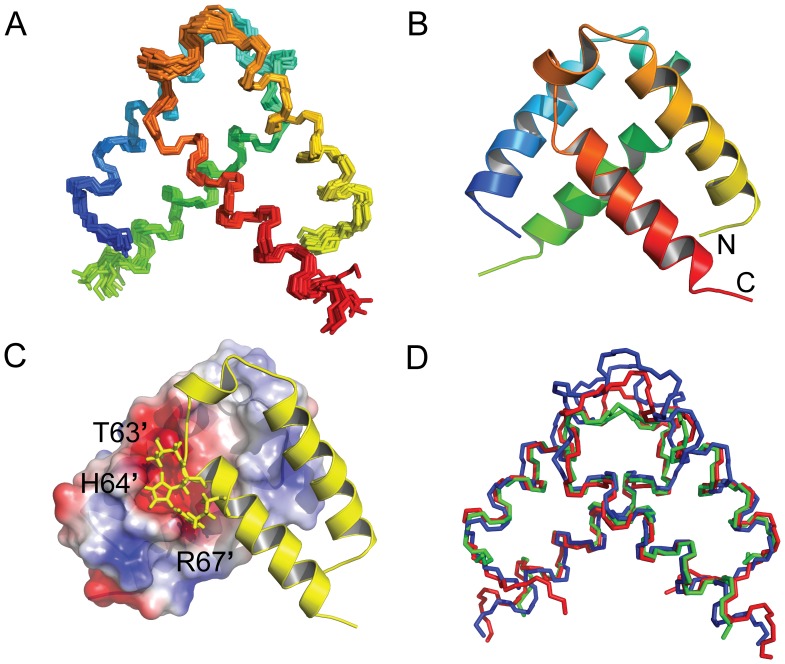
Solution structure of the of pXqua QUA1-C59S dimer.(A) backbone overlay for the final ensemble of 20 lowest energy structures, with protomer A coloured from blue (NT) to green (CT) and protomer B from yellow (NT) to red (CT); (B) ribbon representation of the dimer structure; (C) representation showing the surface of protomer A, coloured according to charge from blue (positive) to red (negative), and protomer B in ribbon form with selected residues displayed as sticks; (D) backbone overlay of QUA1 dimerization domain structures for pXqua C59S (blue), GLD-1 (3K6T; red) and Sam68 (2XA6; green).